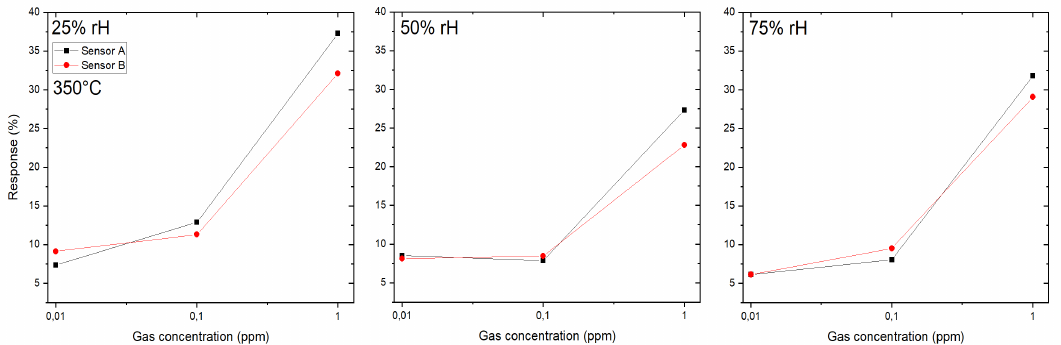
Figure 5. Response of SnO 2 nanowires-based SB sensors towards H 2 S at 350 ◦ C at three different humidity levels—25, 50 and 75%—both (sensor A and B) prepared by the same technology.